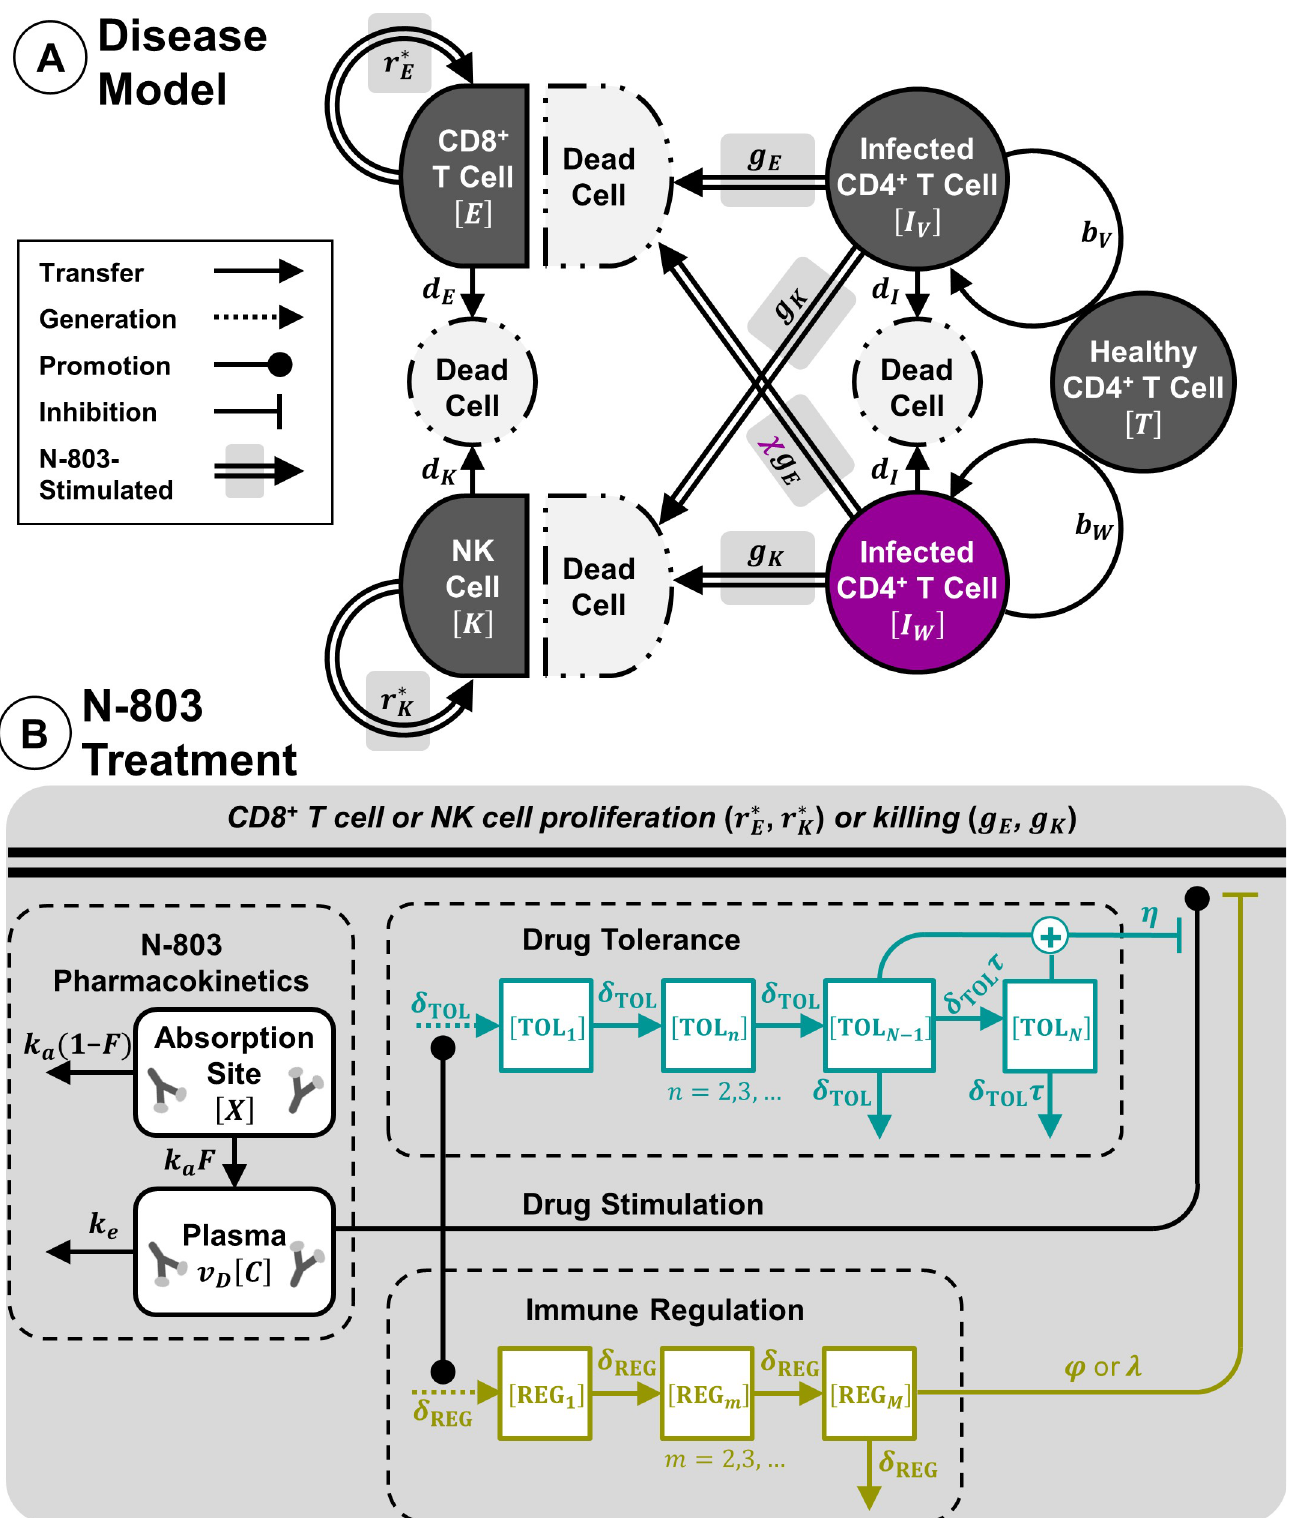
Fig 1. Mathematical model of N-803 treatment of SIV. (A) SIV disease model includes cells infected with one of two variants of SIV virus ( I v and I w ), along with CD8 + T cells ( E ) and NK cells ( K ) (Eqs 1–4). Proliferation rate constants r �